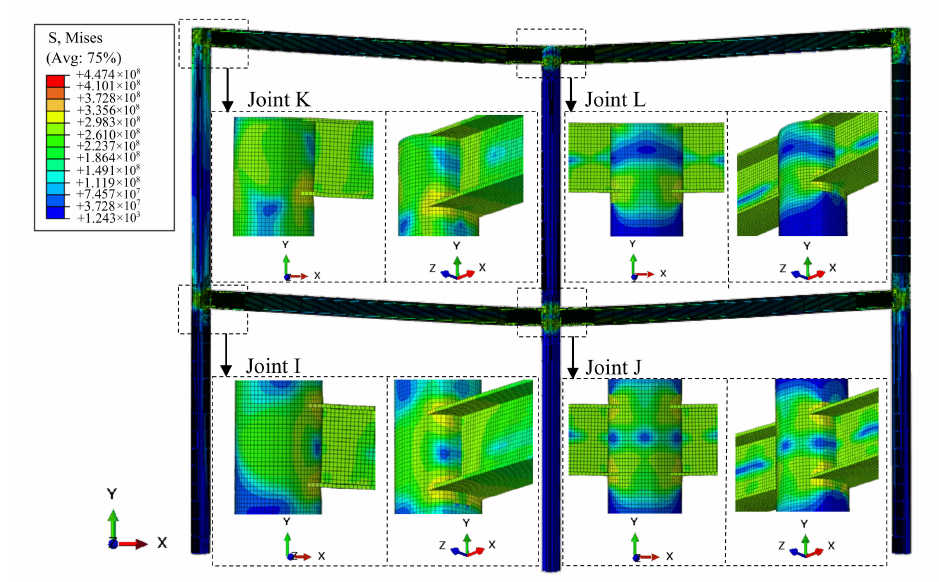
Figure 7. Mises stress cloud diagram of model A c at 15 s under load